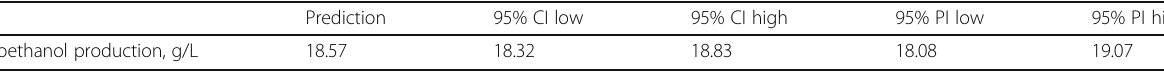
Table 3 Statistical analysis of the predicted solutions